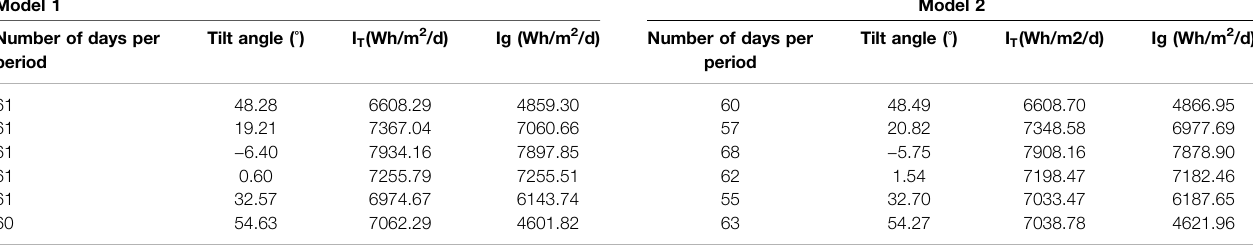
TABLE 4 | Optimal results found for Yanbu city for NP (cid:1) 6.